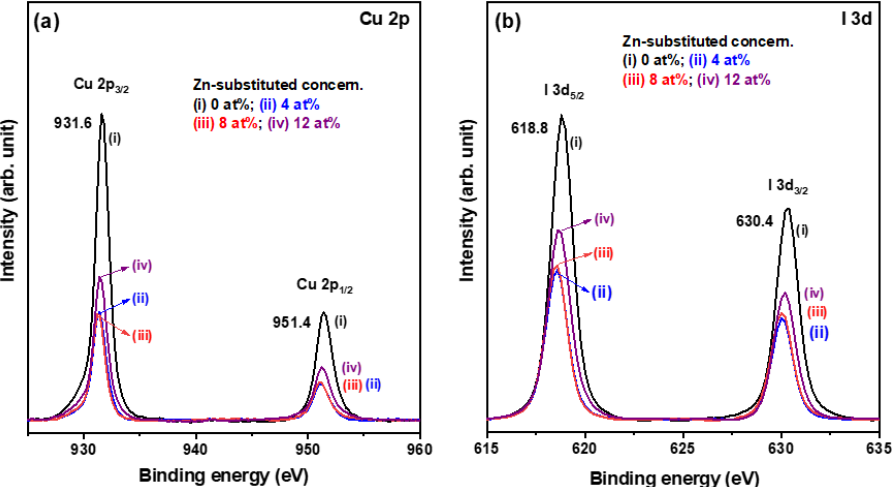
Figure 3. XPS spectra of the core level regions of ( a ) Cu 2p and ( b ) I 3d for the Zn-substituted CuI thin films.